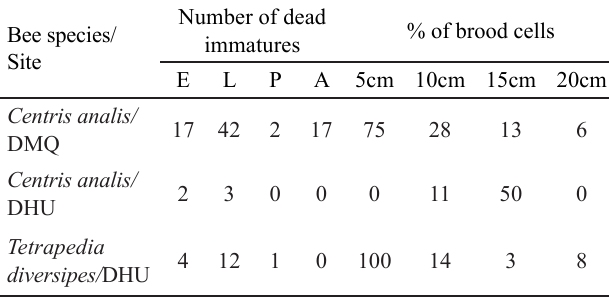
Table 2 . Number of immatures of Centris analis and Tetrapedia diversipes dead in the nests and percentage of brood cells containing dead immatures in cavities of different lengths (5, 10, 15, 20 cm).